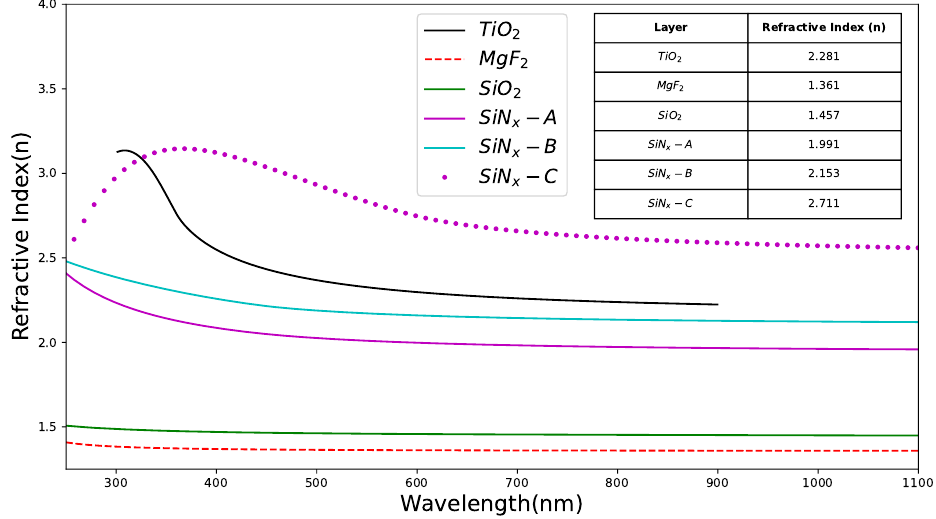
Figure 2. Refractive indices of various ARC